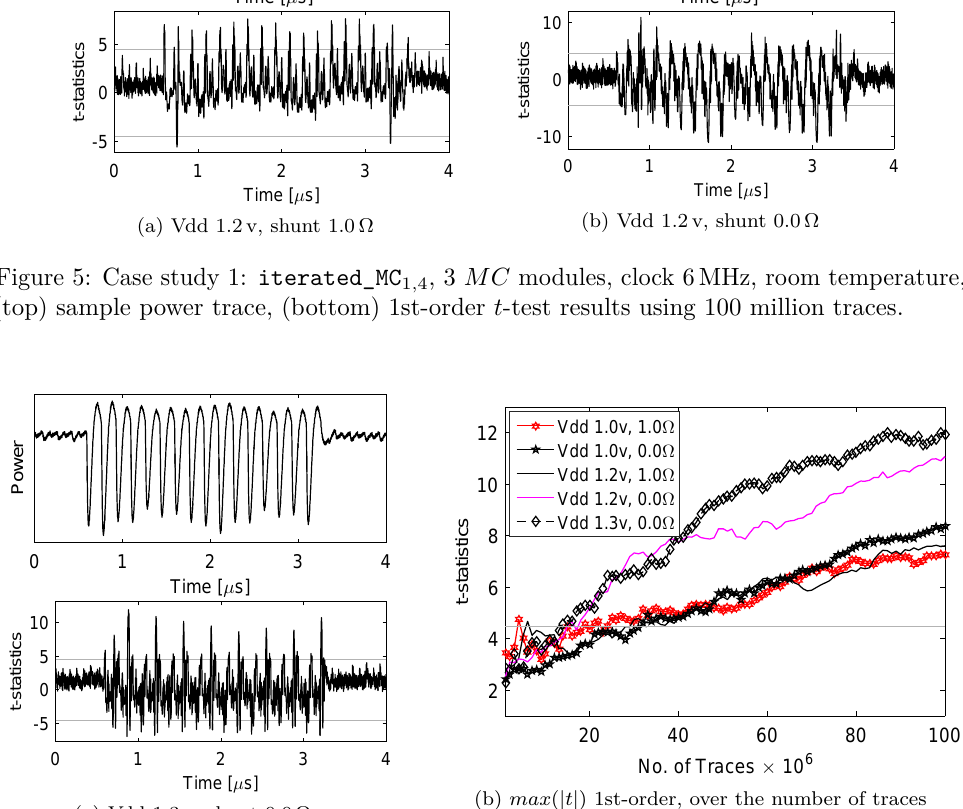
Figure 6: Case study 1: 2 shares, iterated_MC 1 , 4 , 3 MC modules, clock 6 MHz, room temperature, (left, top) sample power trace, (left, bottom) 1st-order t -test results using 100 million